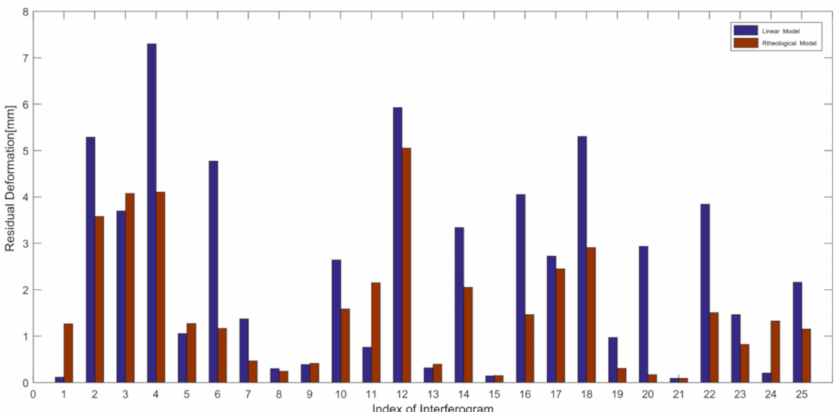
Figure 12. RMS of residual deformation of a 25-interferogram comparison for two models.